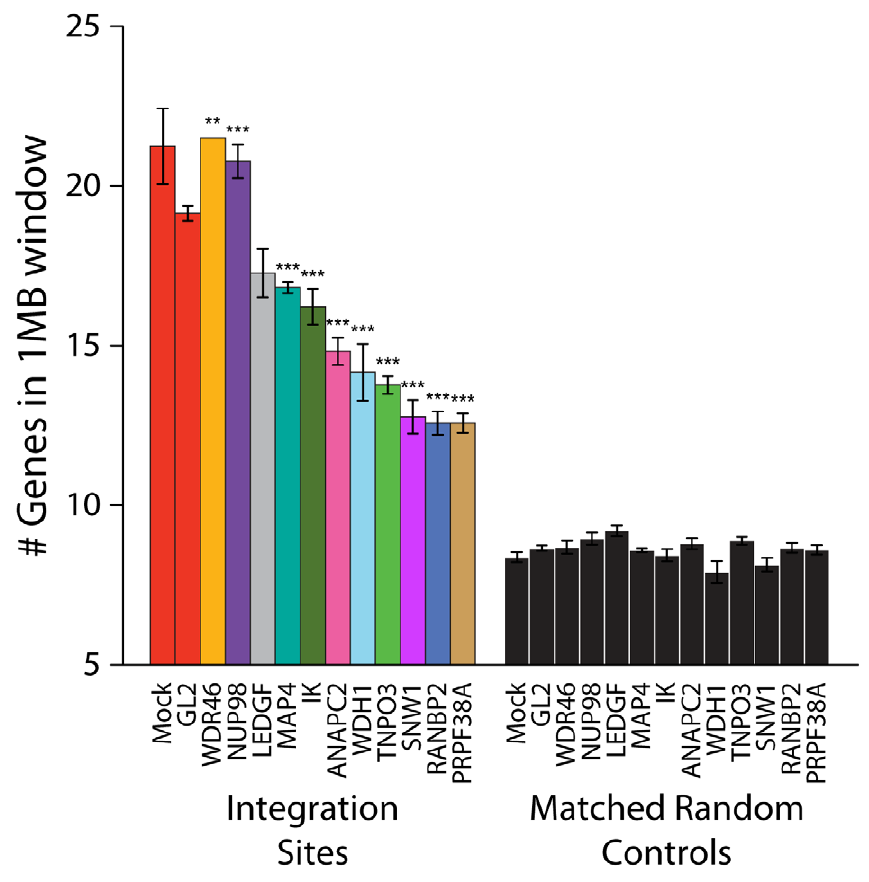
Figure 5. Depletion of additional host factors and their effects on HIV integration in gene dense regions. Integration sites were isolated from cells treated with siRNAs targeting the indicated genes. The average numbers of RefSeq genes in 1 Mb windows surrounding integration sites are shown. Data for a given gene knockdown is the average over multiple siRNA knockdowns using different siRNAs and pools of siRNAs targeted to the same gene, except for Mock, control siRNA (GL2), and LEDGF knockdown conditions for which single treatments were used. Asterisks denote significant difference from control GL2 siRNA-treated cells as determined by the Mann–Whitney test (*P , 0.05; **P , 0.01; ***P , 0.001). Error bars represent standard error for biological replicates. For LEDGF only one dataset was available.